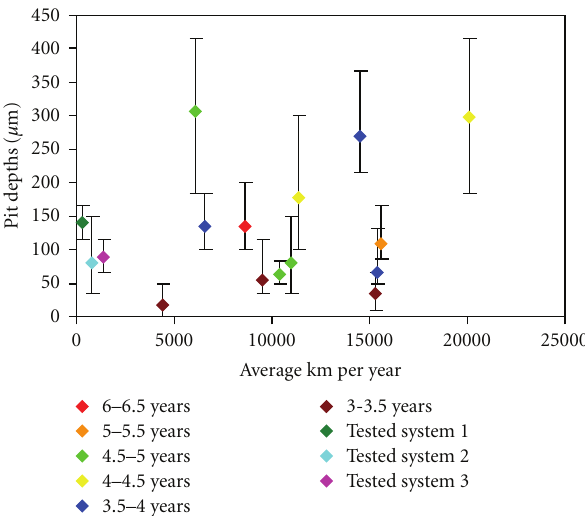
Figure 5: Comparison of all field and three tested